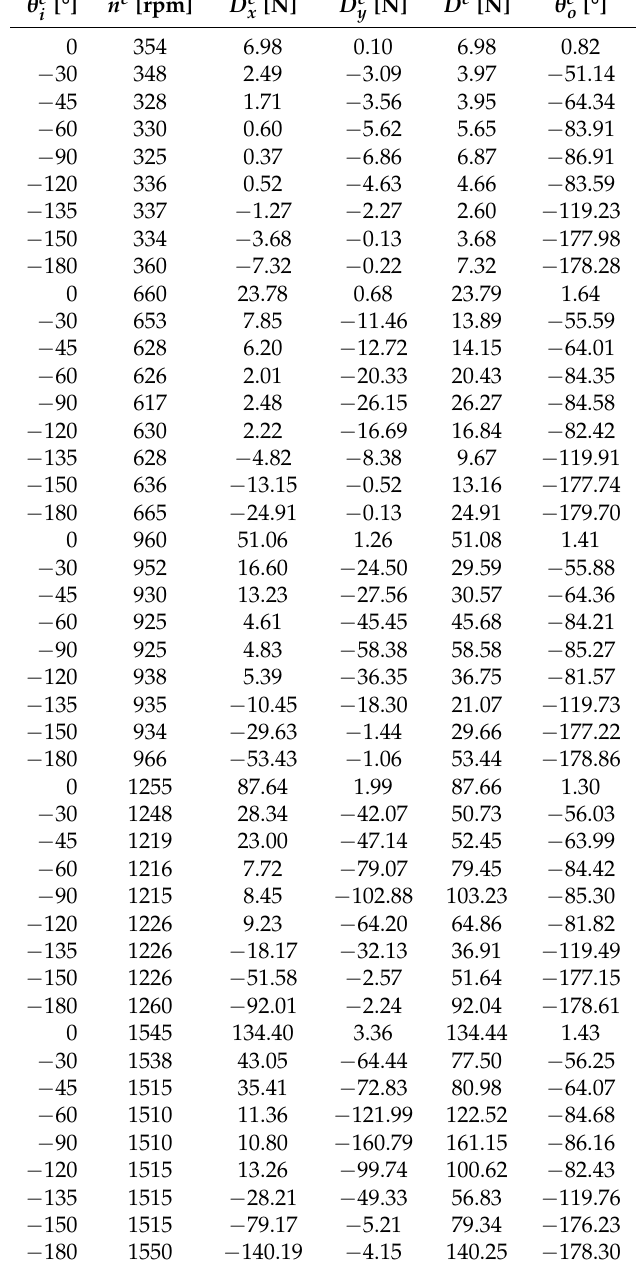
Table A2. Towing tank measurements of the 360-degrees-steerable four-channel stern